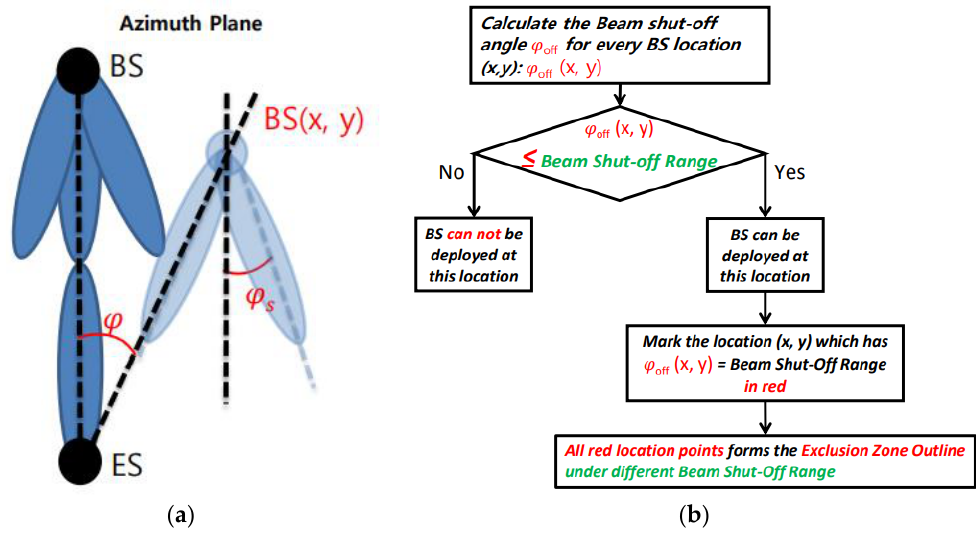
Figure 10. Combination of the exclusion and restriction zones: ( a ) angular protection and ( b ) flux gram.